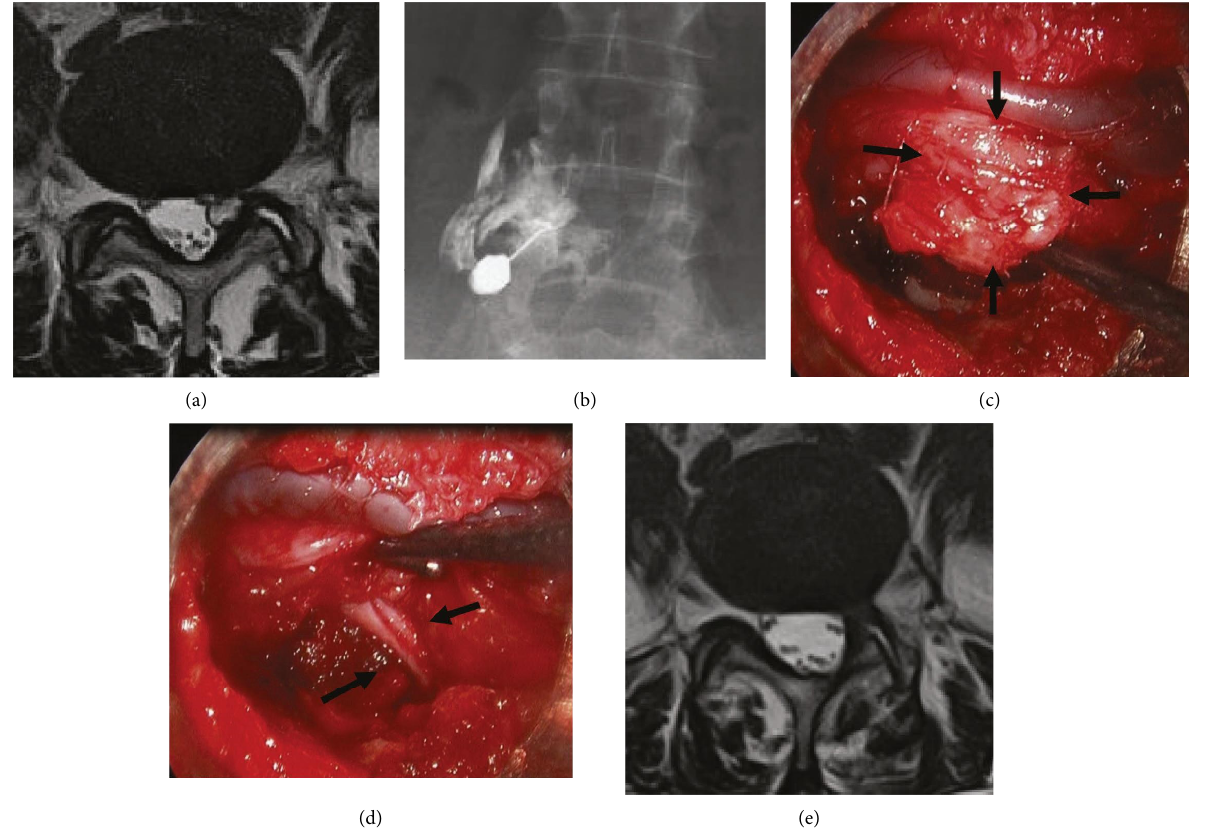
Figure 6: Te case with failed rupture of the cyst: (a) pretreatment MRI, (b) failed rupture of the cyst, (c) before cyst resection (arrow; cyst), (d) after cyst resection (arrow: L5 root), (e) postoperative MRI. MRI, magnetic resonance